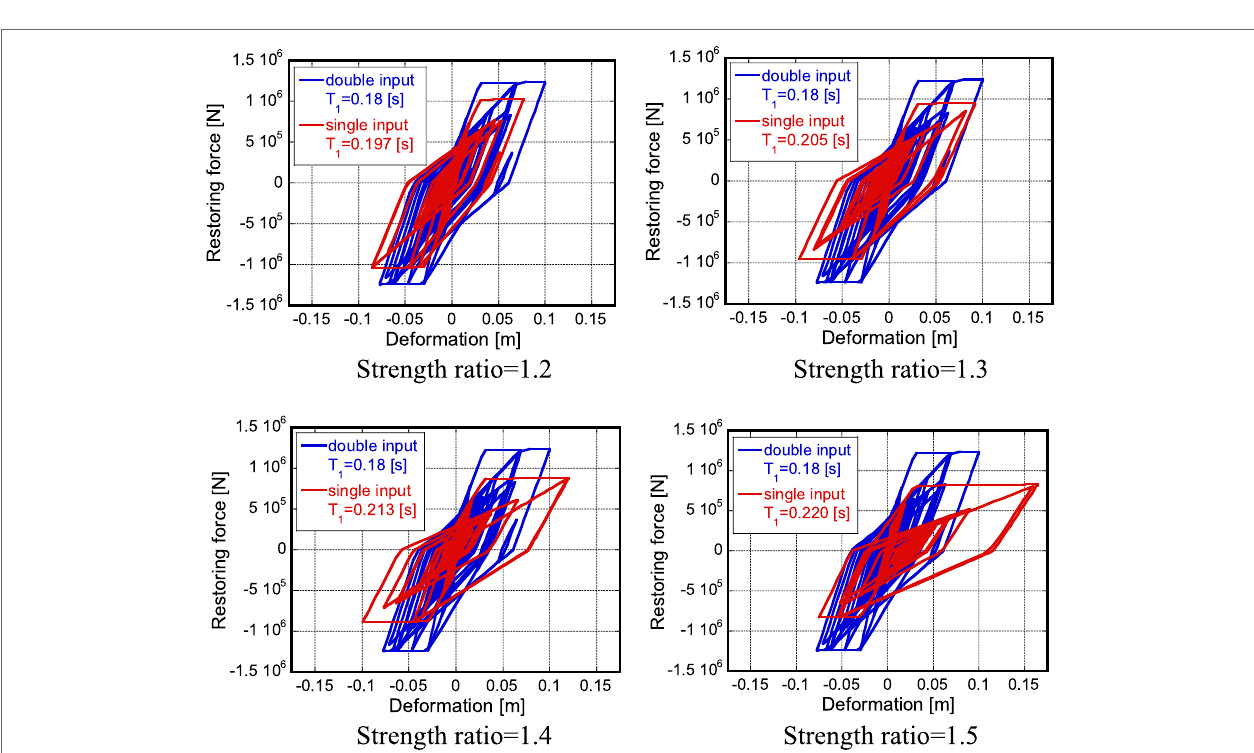
FIGURE 16 | Restoring-force characteristics of models with different strength ratios under repeated 2016 Kumamoto earthquake ground motion (April 16) designed so that they just collapse after one impulse or two impulses [reference model: collapse just after two impulses/Takeda model (reinforced-concrete structures)]